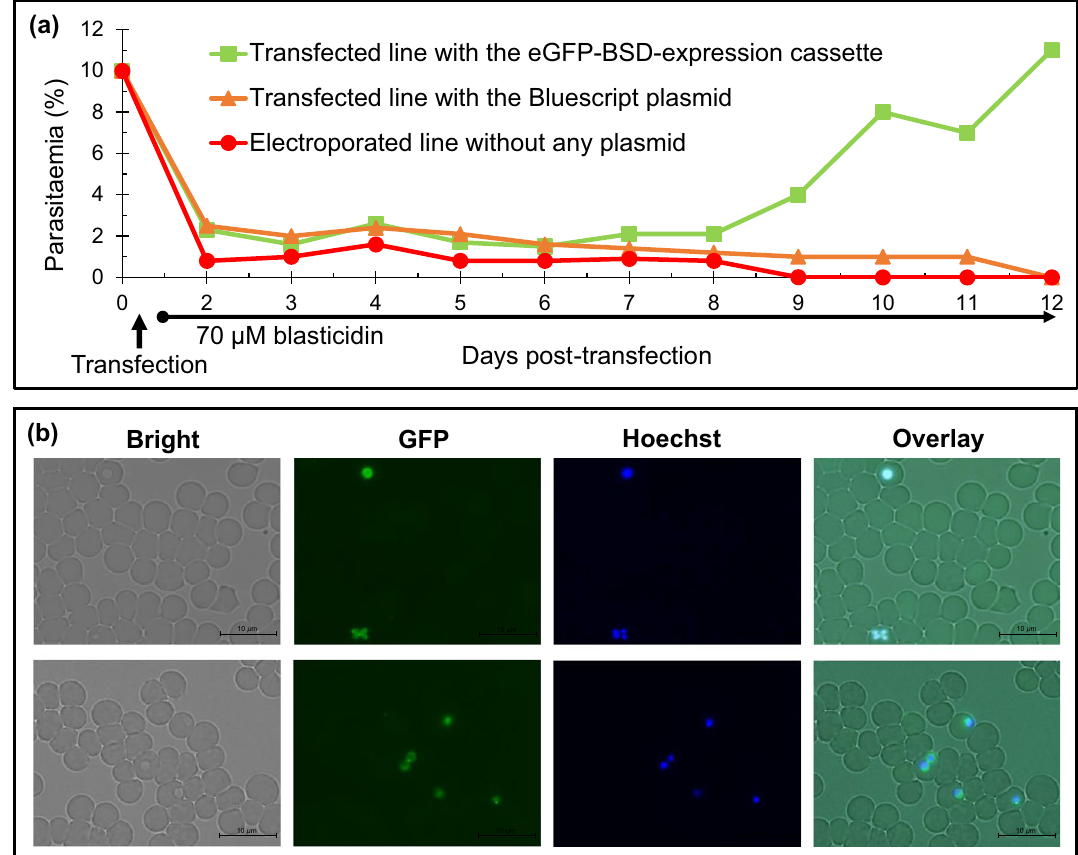
Figure 2. Transfection and isolation of the enhanced green fluorescent protein/blasticidin S deaminase (eGFP/ BSD)-expressing transgenic T . equi parasite . ( a ) Selecting the T . equi transgenic line using blasticidin pressure. Blasticidin treatment was initiated on day 1 post-transfection. Blasticidin-resistant T . equi emerged on day 9 post-transfection. ( b ) Visualisation of T . equi at one year after the isolation of clonal line. A green fluorescent signal was emitted in both the merozoite (ring, paired, and Maltese cross forms) and trophozoite (ring form) stages of the transfected parasites.